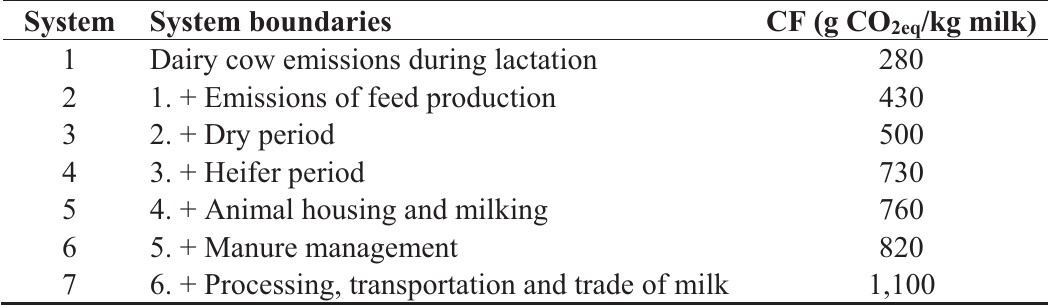
Table 3. Model calculation to demonstrate the effects of setting different boundaries for CF of milk (g CO per kg milk; 30 kg milk per day; diet on DM-base: 60% roughage, 2eq 40% concentrate; 4% milk fat, 3.4% protein; 305 days of lactation; 60 days dry period, 3 years lactation; 30 months calf and heifer period